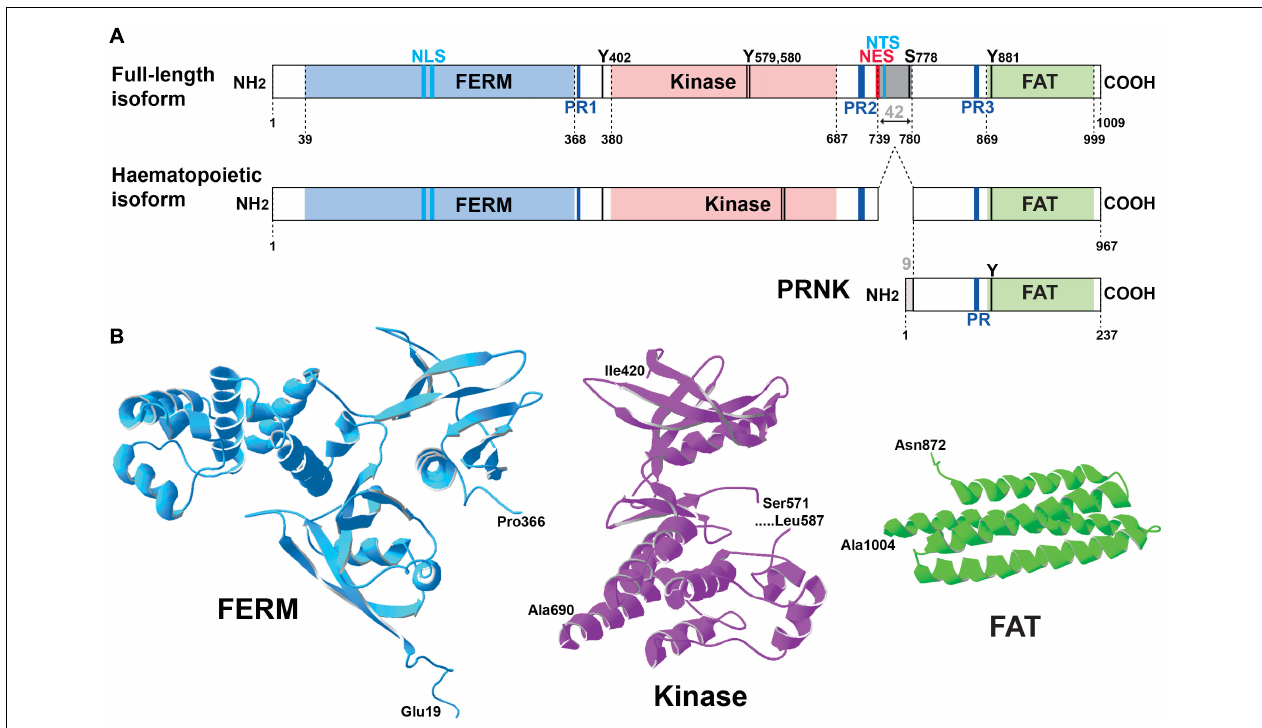
FIGURE 1 | Pyk2 structure. (A) Schematic representation of Pyk2 protein isoforms. The limits of the structural domains are indicated with the first and last residue (numbering of mouse Pyk2): FERM, 4.1-ezrin-radixin-moesin, FAT, focal adhesion targeting. A Pyk2 protein isoform observed in cells of the hematopoietic lineage results from alternative splicing with the absence of an exon coding 42-amino acids (gray box). PRNK (Pyk2-related non-kinase) is a short isoform that derives from transcription initiation at an internal promoter and consists of the C-terminal region of Pyk2 with 9 additional residues at its N-terminus that are not found in Pyk2. Other important sites are indicated including the main characterized phosphorylation sites (T, threonine, Y, tyrosine), the proline-rich motifs (PR), the nuclear localization sequence (NLS), nuclear export sequence (NES), and nuclear targeting sequence (NTS). See text for references. (B) Three-dimensional structure of the main domains of Pyk2 for which the crystal structure has been determined. The structures were drawn with Deep View/Swiss Pdb viewer (http://www.expasy.org/spdbv/) for the FERM (pdb4eku), kinase (pdb4h1m), and FAT (pdb4gm3)